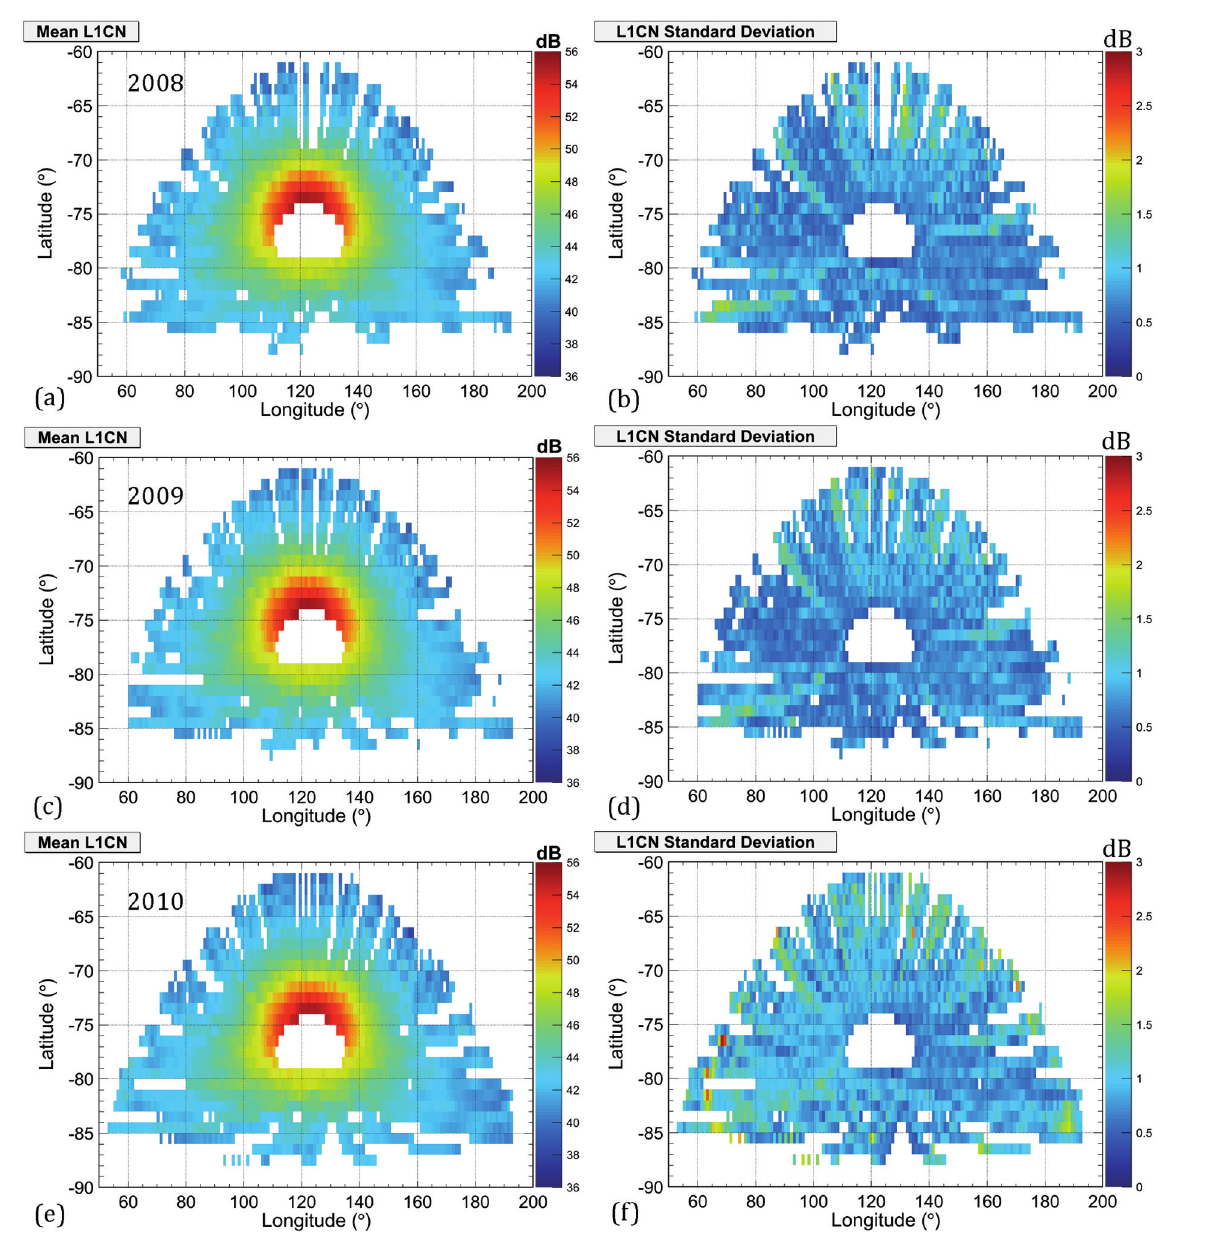
Figure 5. Maps of the L1C/N mean (left column) and SD (right column) in geographic coordinates for the three years of data: 2008 (a, b), 2009 (c, d) and 2010 (e,